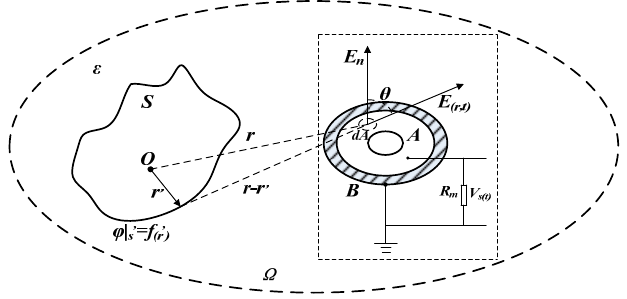
Figure 5. Principle of sensor measurement.